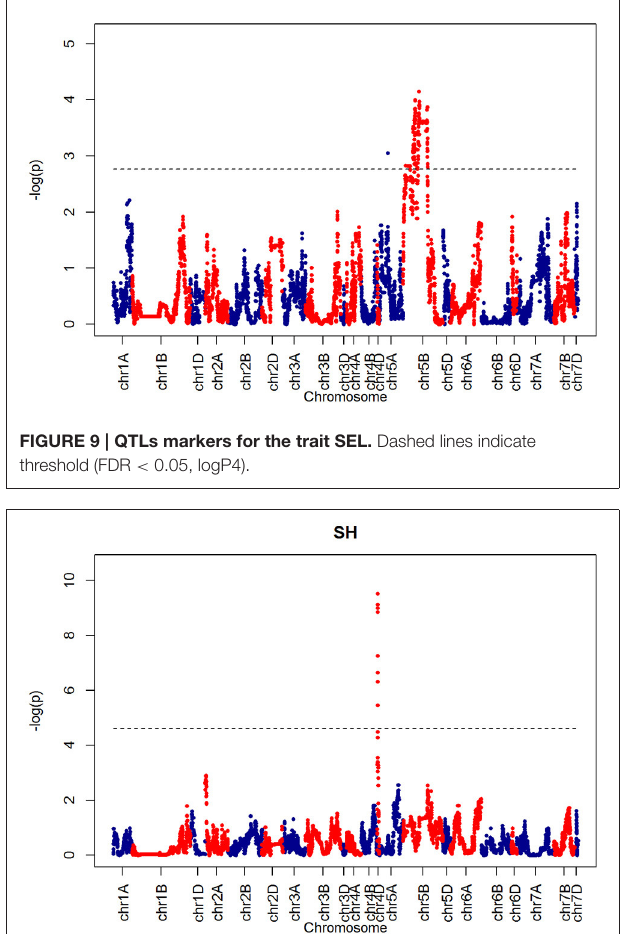
FIGURE 10 | QTLs markers for the trait SH. Dashed lines indicate threshold (FDR < 0.05, logP4).